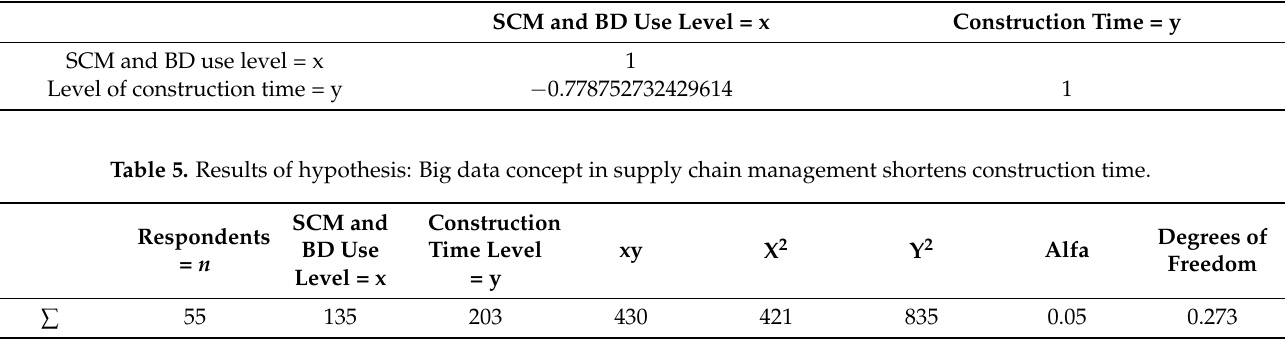
Figure 5. (a) Correlation between the examined variables (level of SCM and BD usage and construction time level) and (b) linear correlation between variables Table 4. Pearson correlation (SCM and BD use level and constriction time level).